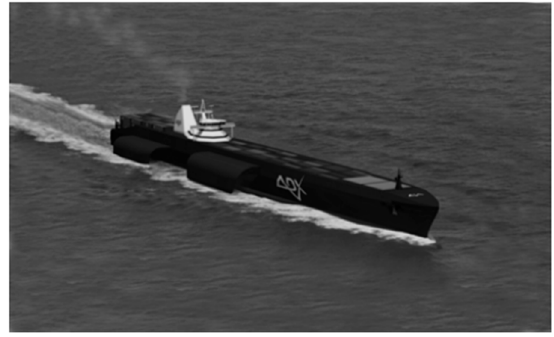
Figure 1. The concept design of a pentamaran [7].